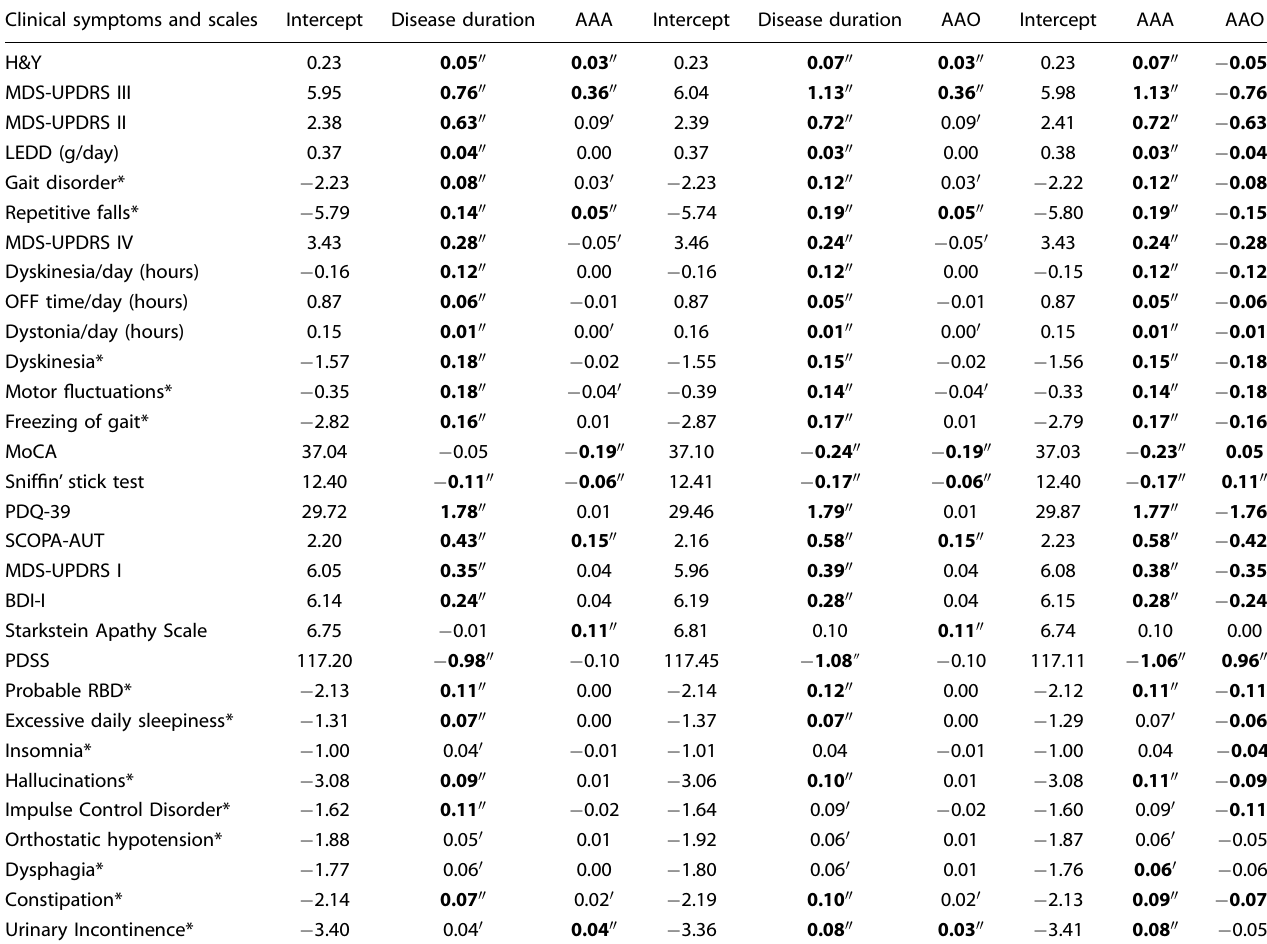
Table 3. Multiple regression of clinical outcomes on age at onset (AAO), age at assessment (AAA) and disease duration for Parkinson ’ s disease group. Clinical symptoms and